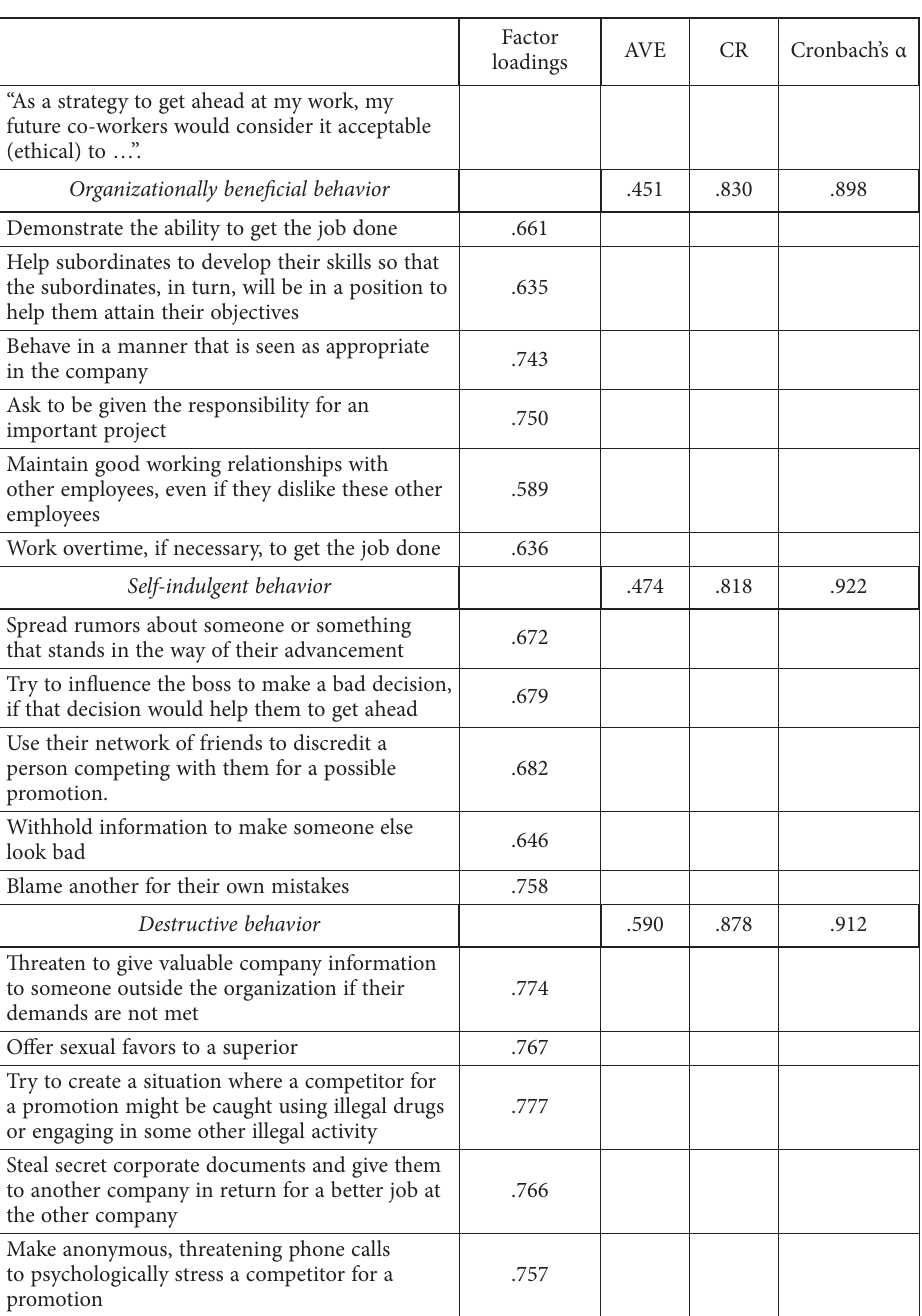
Table 1. Measurement items, factor loadings, AVE, CR, and Cronbach’s alpha for three groups of strate- gies for advancement in the workplace (created by the authors) Factor